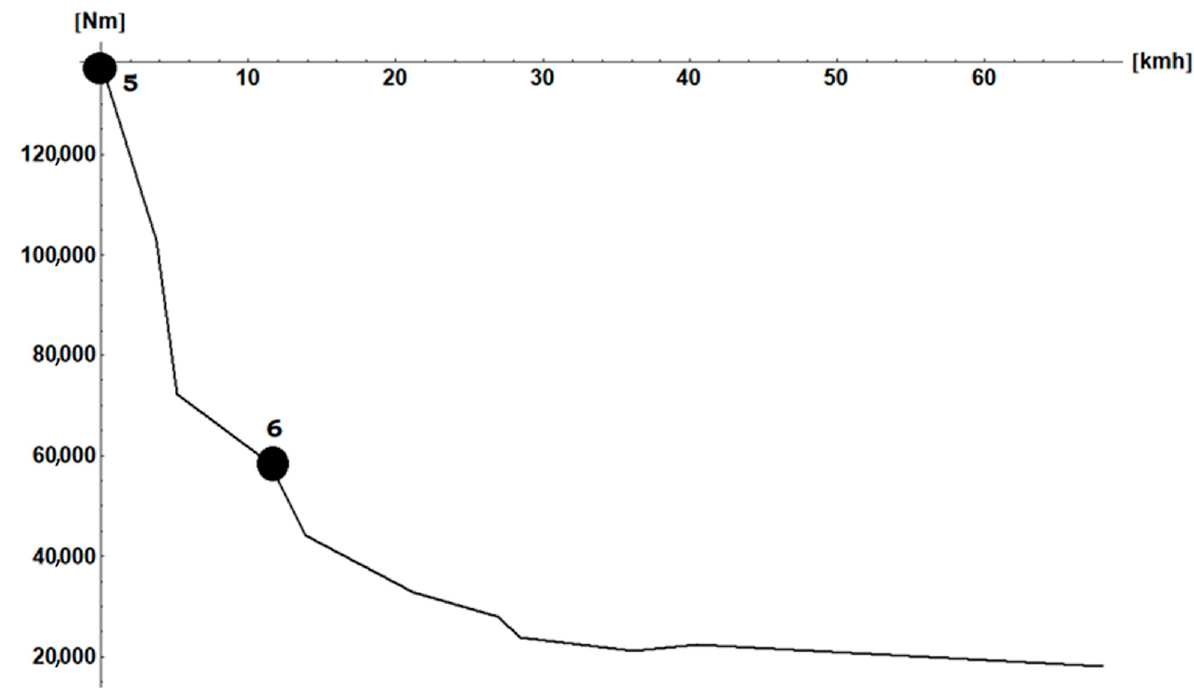
Figure 4. Available torque vs. speed for a typical, traditional MBT power pack [16].